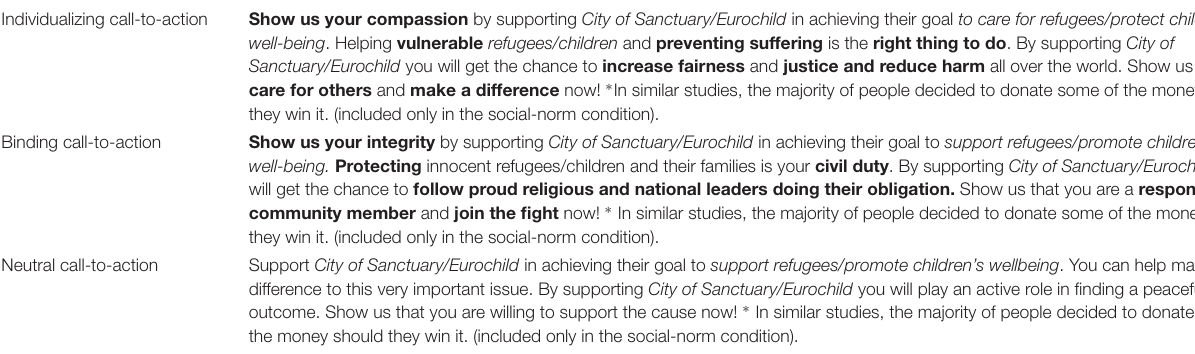
TABLE 1 | Calls-to-action that are going to be used in the study. Individualizing